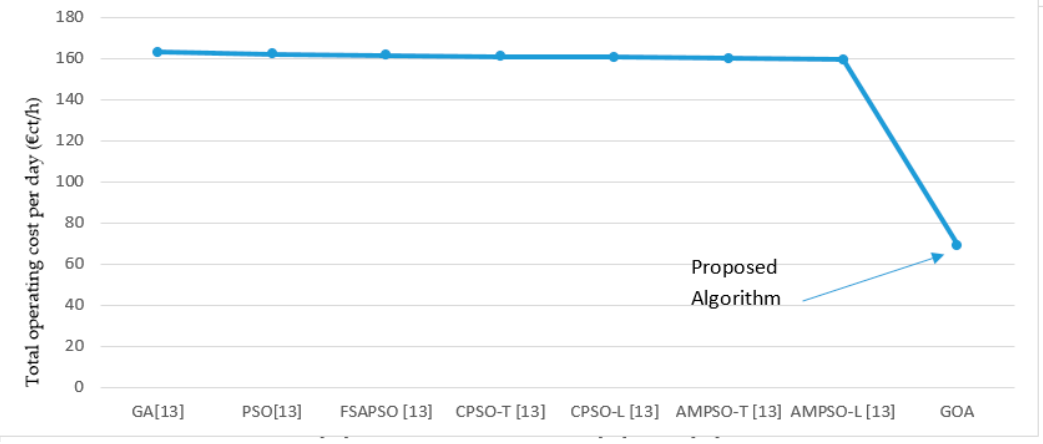
Figure 18. Comparison of the simulation results for the second scenario.